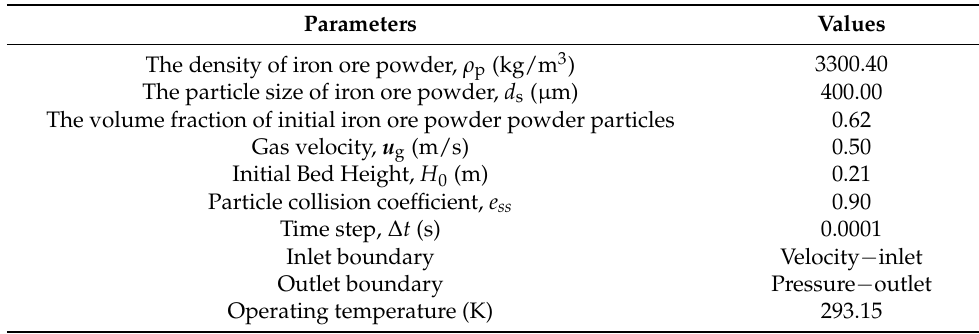
Table 1. Relevant simulation